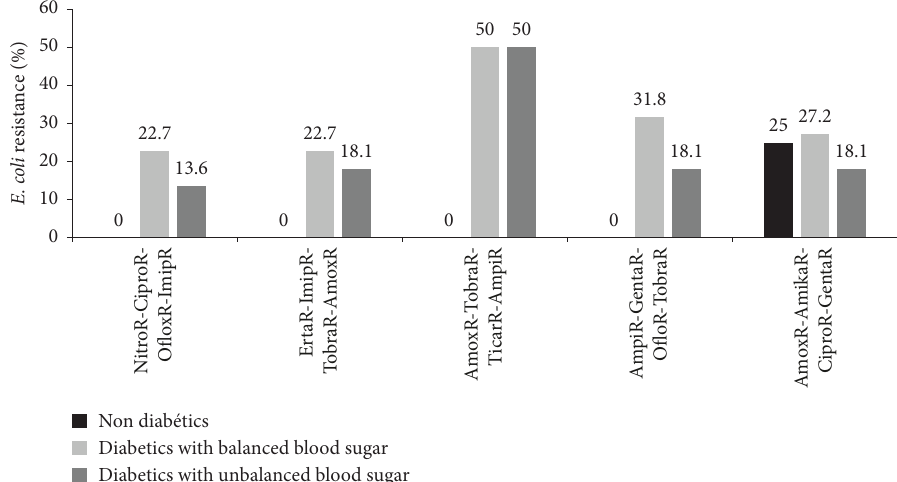
Figure 5: Distribution of E. coli resistance to quadruple antibiotics as a function of diabetic status. Amika: amikacin, Amox: amoxicillin, Ampi: ampicillin, Cipro: ciprofoxacin, Erta: ertapenem, Genta: gentamicin, Ofox: ofoxacin, Ticar: ticarcillin, Tobra: tobramicin, Imip: imipenem, and Nitro: